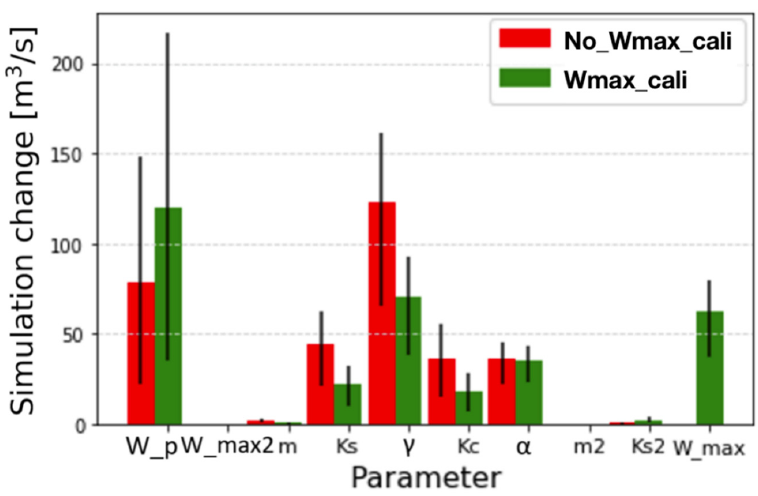
Figure 2. Simulation changes from sensitivity tests of model parameters in the cases without and with W_max calibration across 15 individual flood event runs. Water 2020 , 12 , x FOR PEER REVIEW